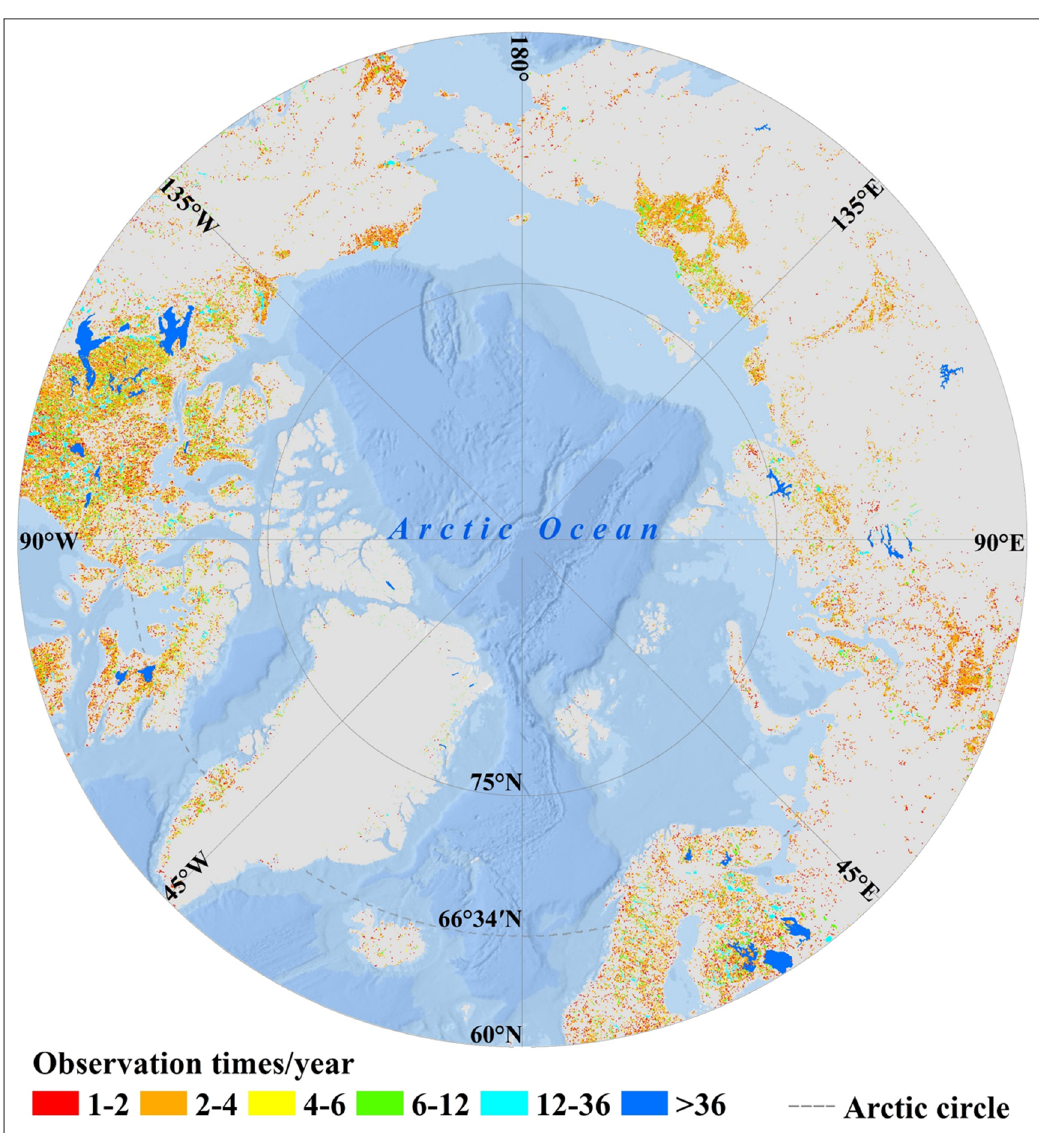
Figure 3. Spatial patterns of observed lakes with annual number of observations. Among the 80,688 observed lakes in the HydroLAKES database, at least 40,192 lakes (~50%) could be observed by the ICESat-2 in Category 1 (wet/dry season coverage) (Table 2), which cover 84% of the area and 95% of the volume of pan-Arctic lakes. Another 50% of lakes that do not meet the seasonal observed characteristics are labeled